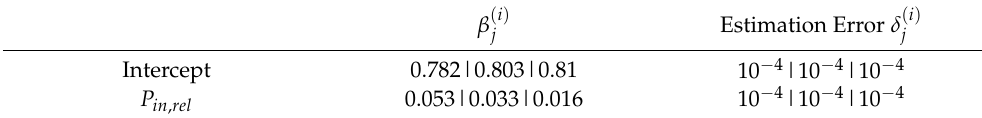
( i ) , and Prediction Errors (cid:101) for the three sub-data sets P in , rel ∈ j